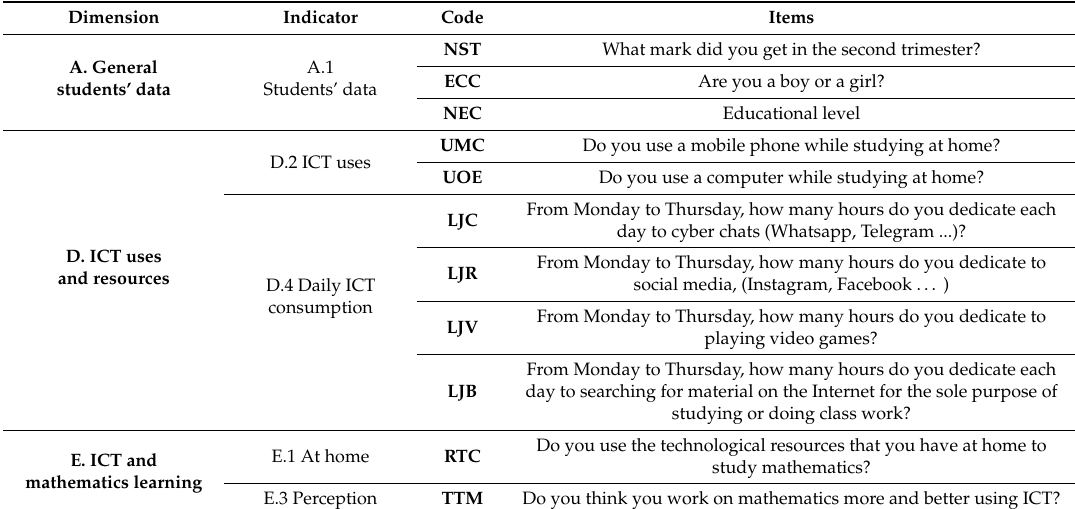
Table 1. Relationships among dimensions, indicators, and